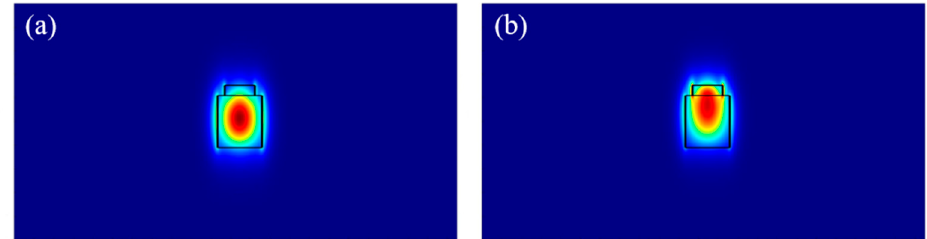
Figure 4. The modal intensity profiles of a silicon waveguide loaded with a GSST strip in the ( a ) amorphous and ( b ) crystalline states.